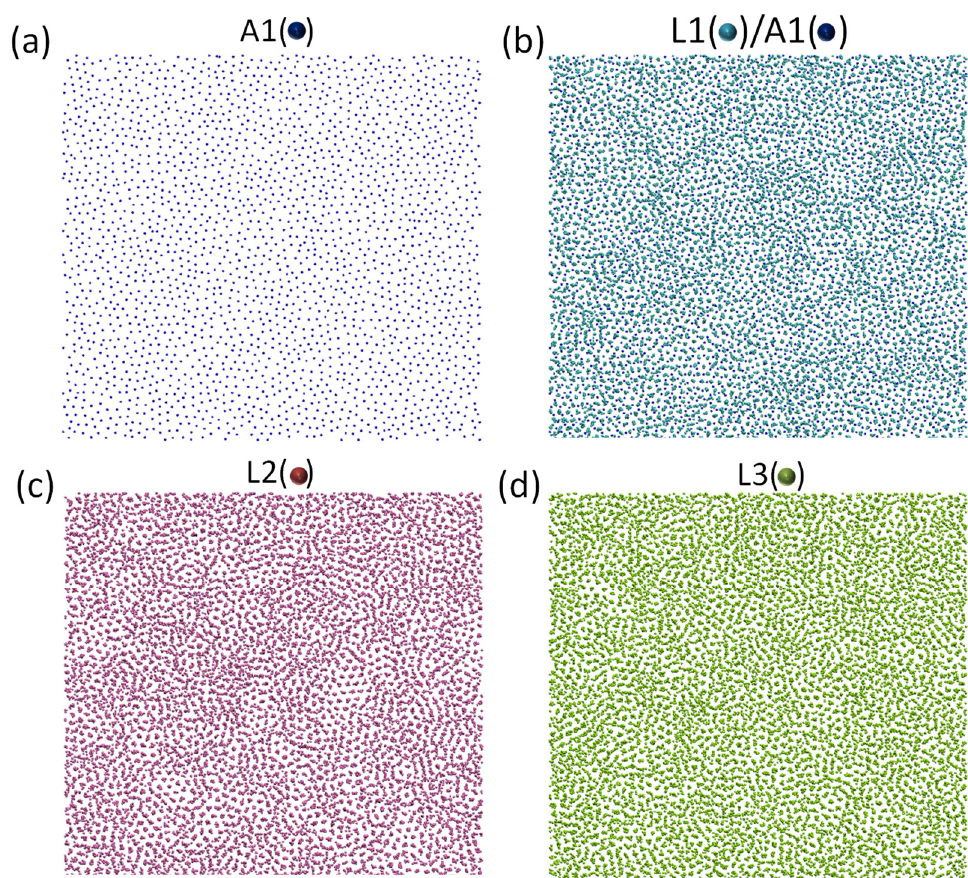
Figure 12. Local ordered structure in the liquid at the liquid/amorphous substrate with a smooth surface [64]. Time-averaged atomic positions of ( a ) A1, ( b ) L1/A1, ( c ) L2, and ( d ) L3 for the simulation system with 2D amorphous substrate at t = 100 ps during the simulation at T = 579 K. The local short-range order in the amorphous substrate can template solid clusters in the liquid at the interface with the smooth surface of the amorphous substrate.